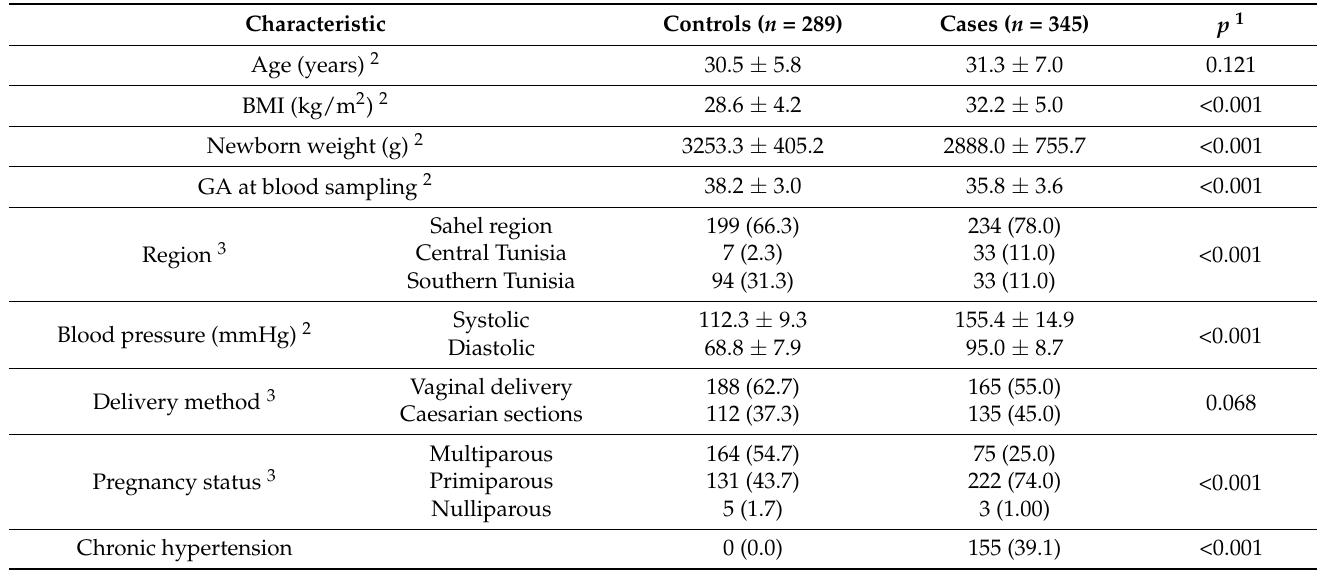
Table 1. Demographic and clinical characteristics of controls and patients.